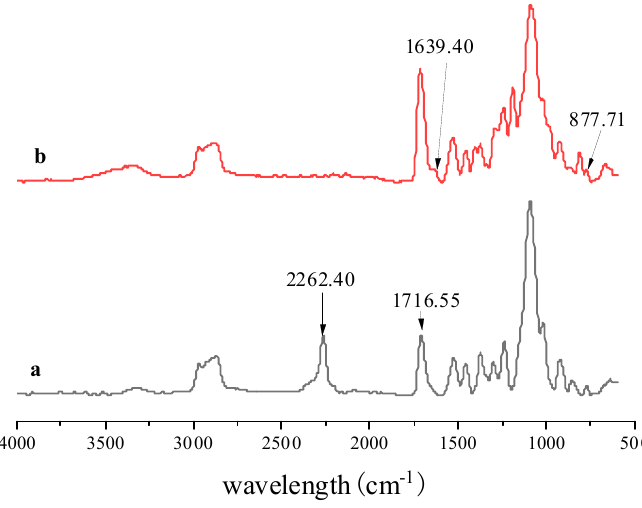
Figure 8. FT-IR spectra of ( a ) polyurethane prepolymer and ( b ) PU-TiO 2.